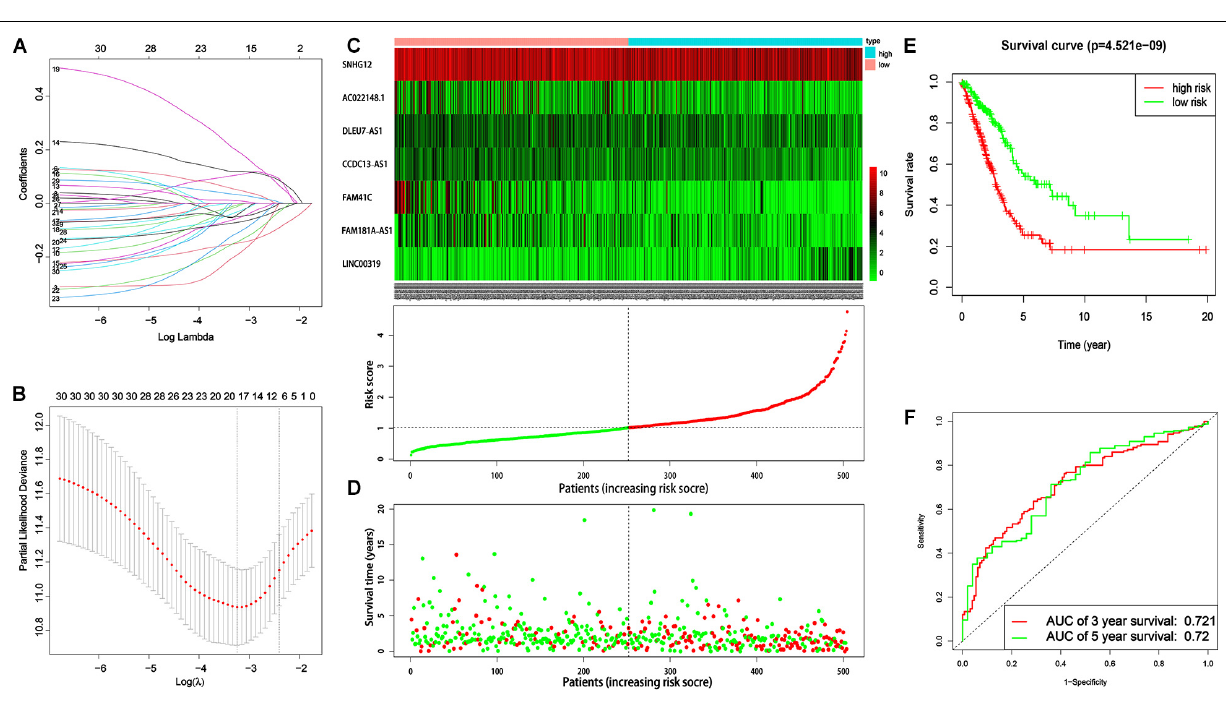
while their risk score distribution, as well as their survival, prognosis than those with high-risk scores ( P = 4.52e − 9 ) ( Figure 4E ). ROC analysis estimated that the AUC values of the lncRNA-based prognostic signature for survival were 0.721 for the third year and 0.72 for the fifth year, respectively ( Figure 4F